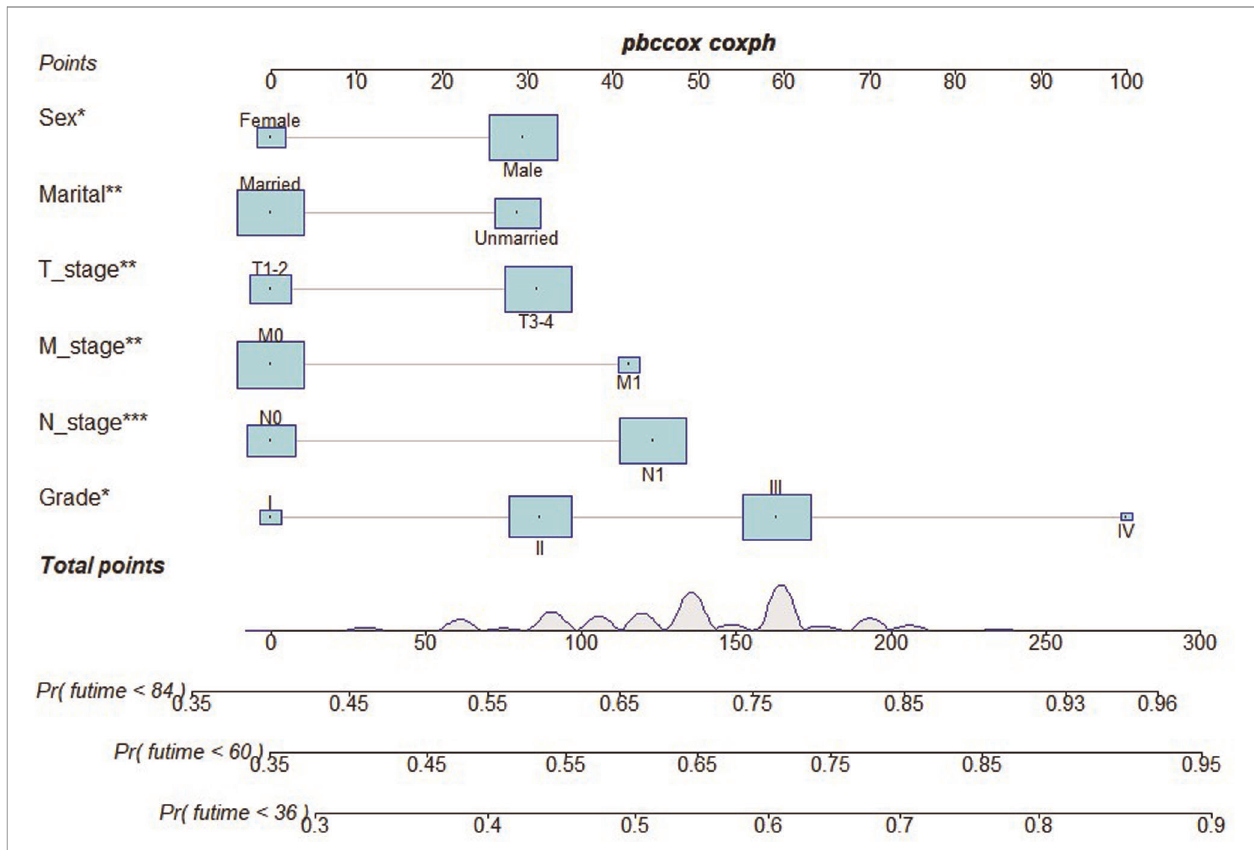
FIGURE 2 | Nomogram model to predict the OS at 36-, 60-, and 84 months in patients receiving neoadjuvant chemoradiotherapy plus